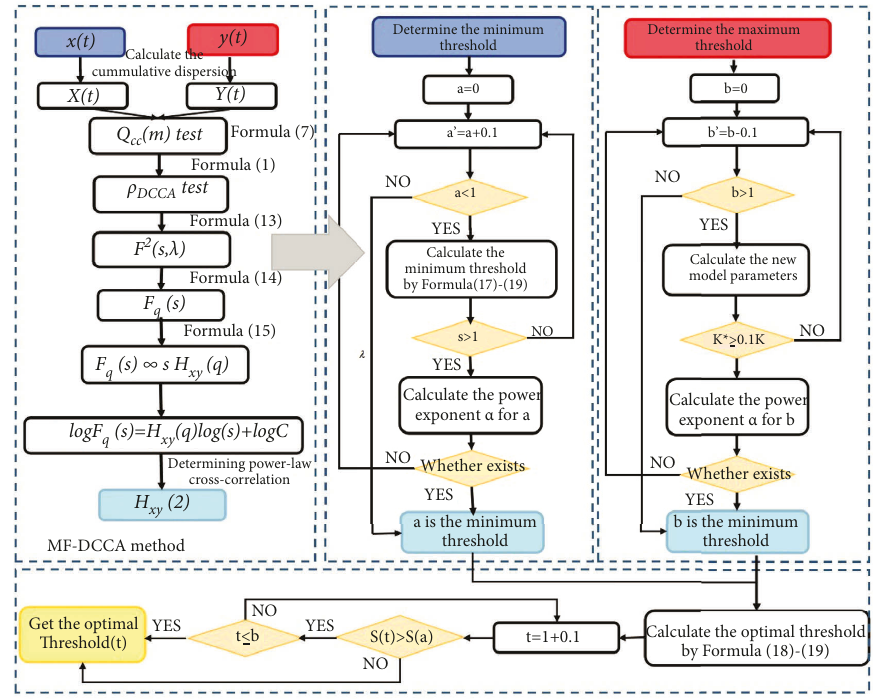
Figure 8: Flowchart of Hurst coefficient and optimal threshold Table 2: Descriptive statistics of time series of some monitoring points.